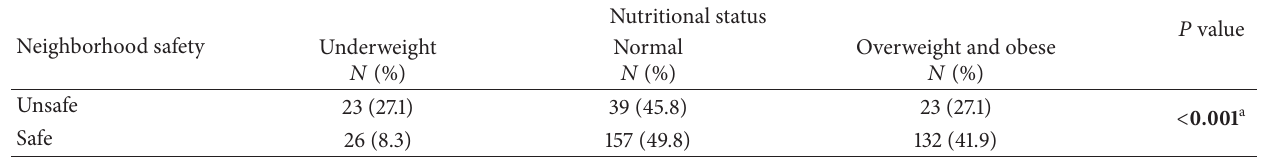
Table 3: The relationship between neighborhood safety status and children nutritional